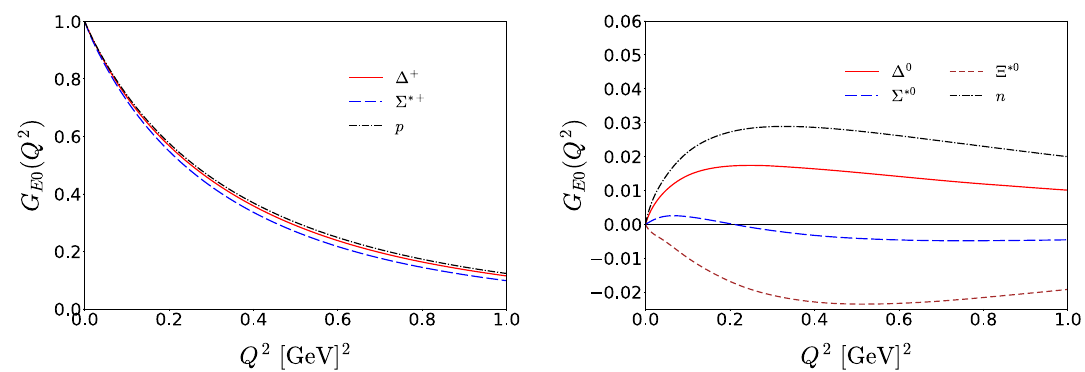
Fig. 14 Electric monopole form factors of the baryon decuplet in comparison with those of the